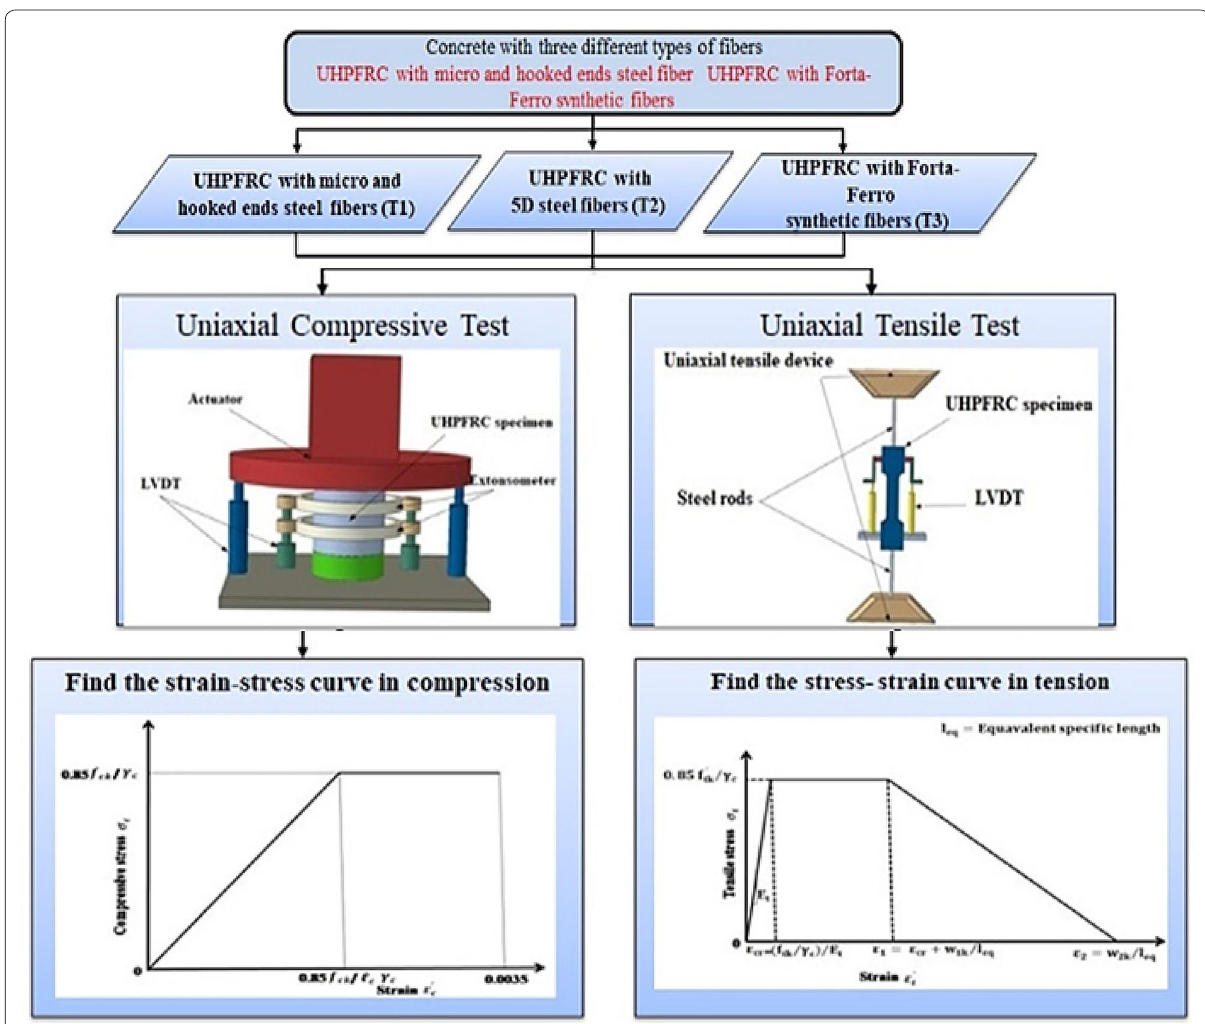
Fig. 1 Material properties of